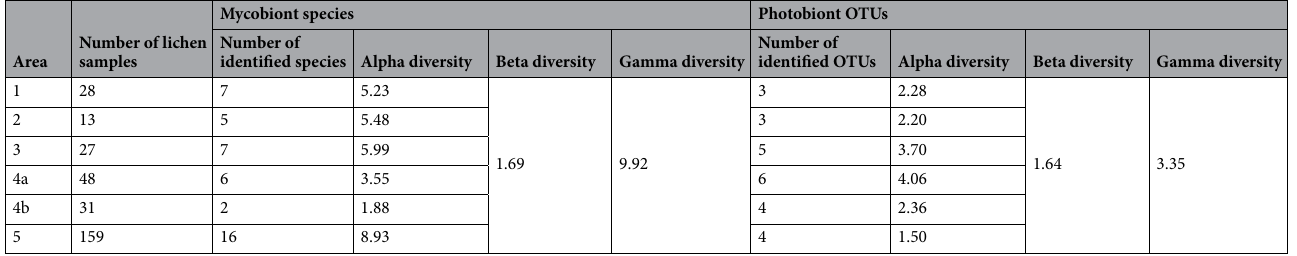
Table 2. Number of lichen samples, number of identified mycobiont species and photobiont OTUs, as well as alpha, beta and gamma diversity values of mycobiont species/photobiont OTUs for the different